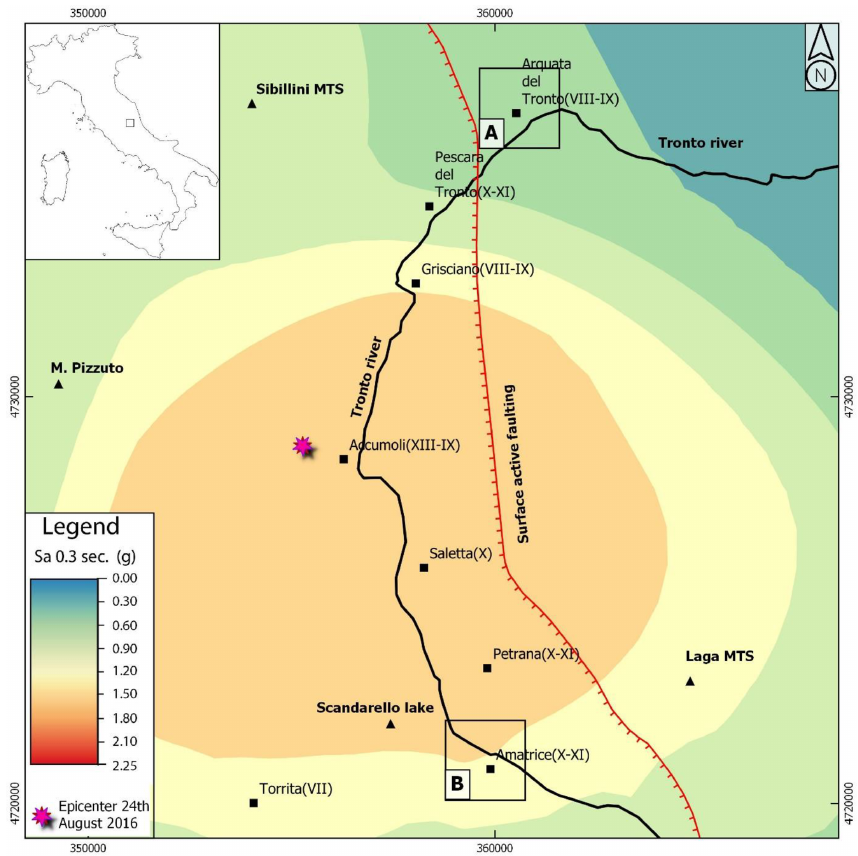
Figure 8. ShakeMap (slightly modified from ShakeMap, 2021) of Sa 0 . 3 regarding the central Italy earthquake that occurred on 24 Au- gust 2016. Squares A and B refer to the close-ups at Arquata del Tronto and Amatrice, respectively. From the center of the figure to the border, the homogenously colored areas correspond to 1.20–1.50, 0.90–1.20, 0.60–0.90, 0.30–0.60, and 0.01–0.30 g intervals. It is evident that the map does not capture the variability at short